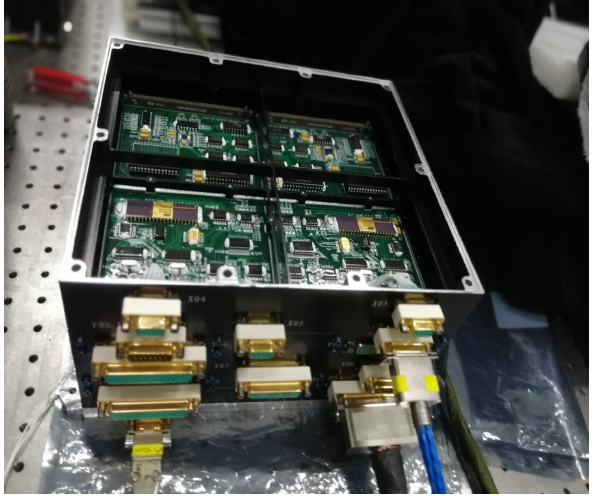
Figure 1. Electronics of the SVOM astronomical camera.